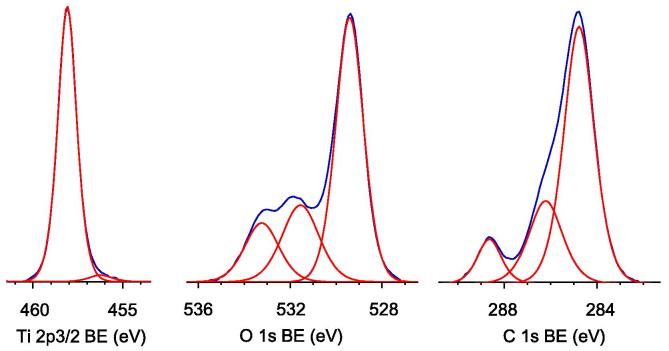
XPS results for Ti 2p3/2, O 1s, C 1s of bare 6 h OAP.